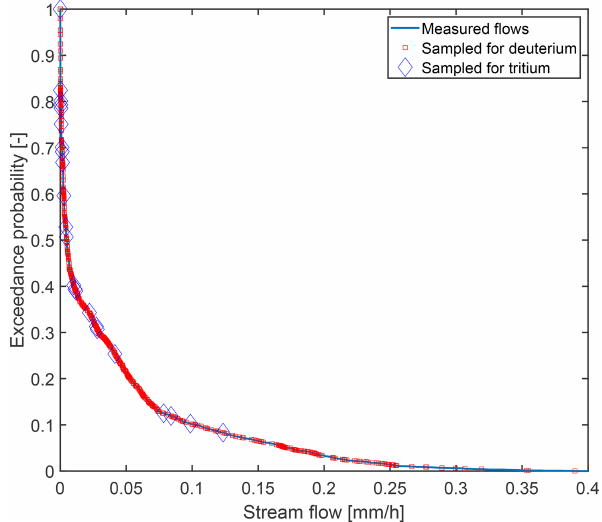
Figure 3. Distribution of stream samples ( 3 H and δ 2 H) along the flow exceedance probability curve defined as the fraction of stream- flows exceeding a given value over